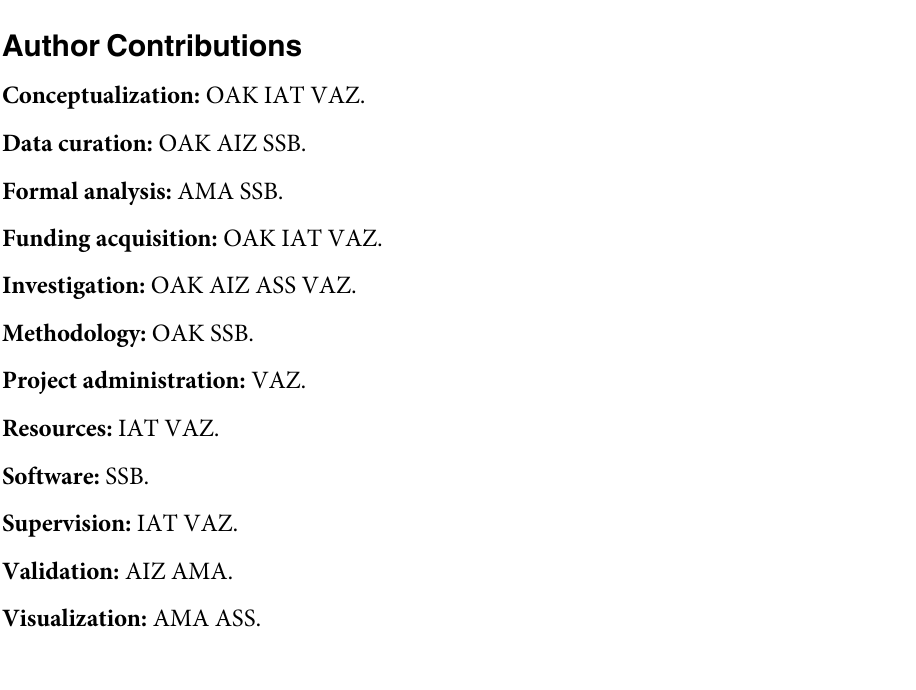
S1 Table. CAPS markers used for Sym13 genetic mapping. S2 Table. CAPS markers used for Sym27 genetic mapping. S3 Table. List of M . truncatula genes located between Medtr4g092760 and Medtr4g096790 , including possible Sym13 candidate genes. S4 Table. List of M . truncatula genes located between Medtr7g058640 and Medtr061018 , including possible Sym27 candidate